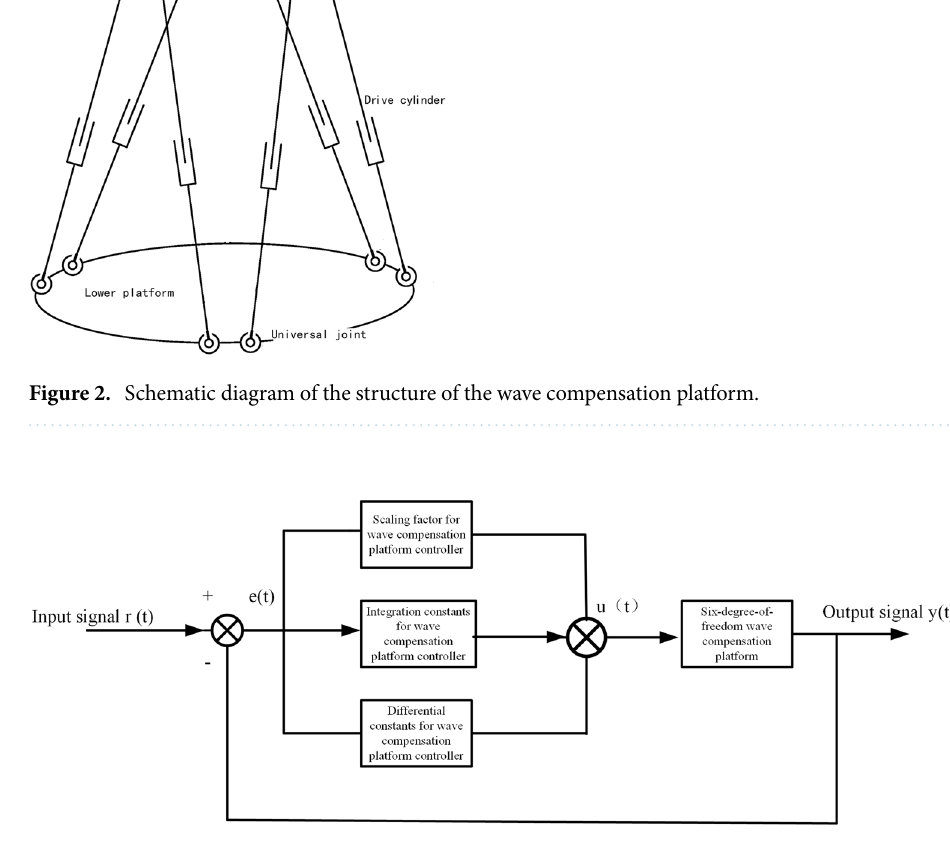
Figure 3. Diagram of PID control principle of ship wave compensation